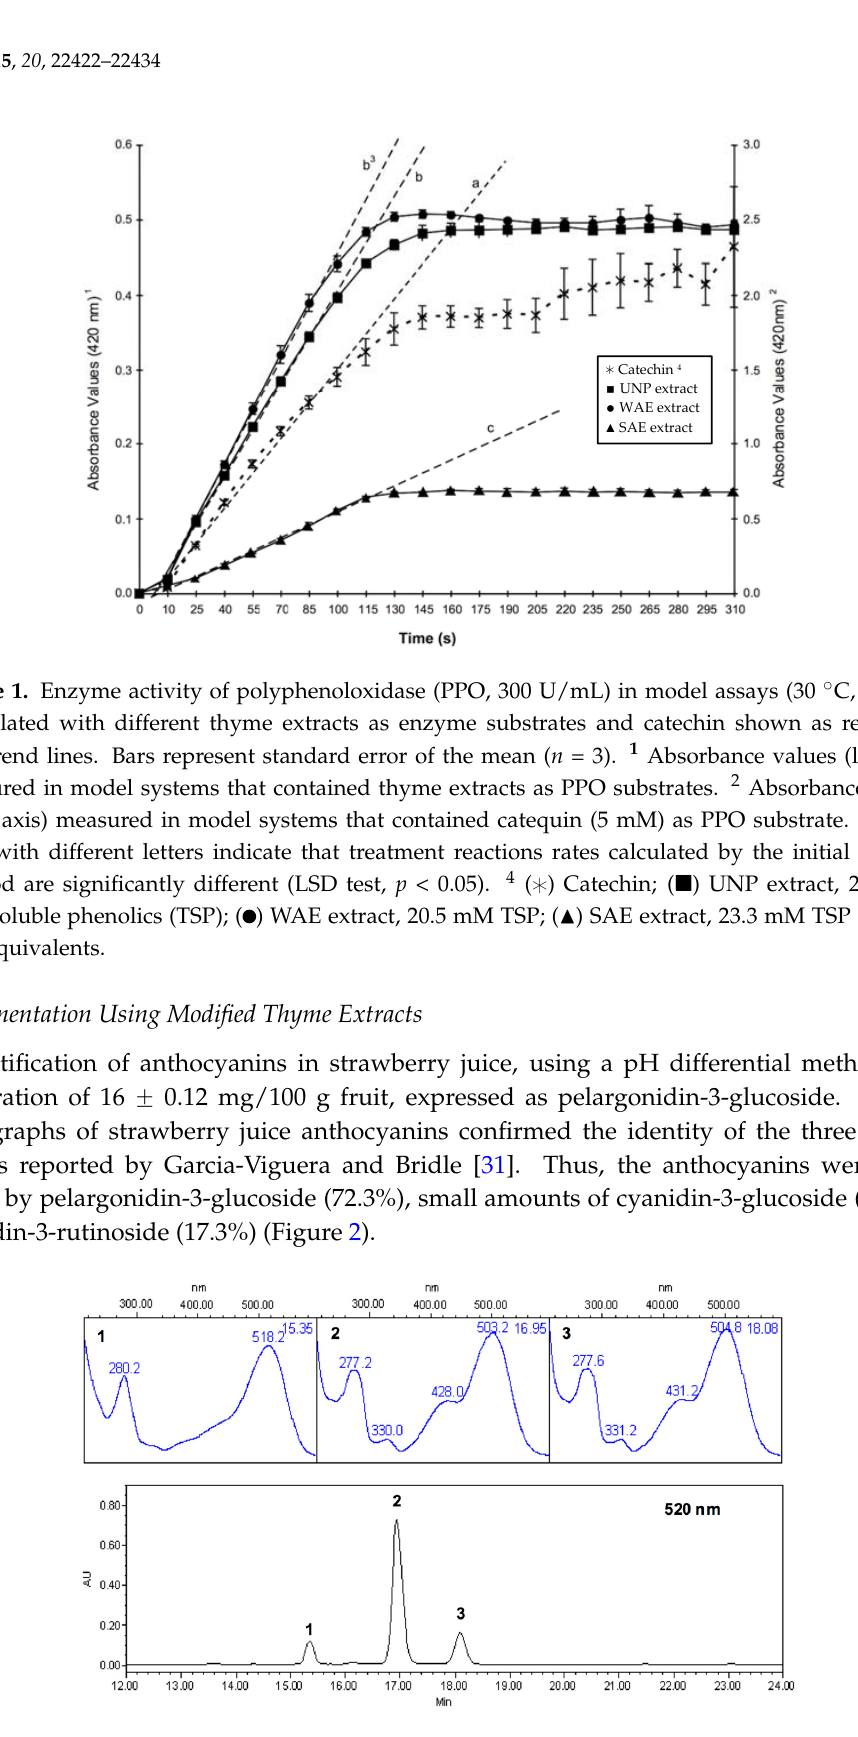
Figure 2. HPLC-PDA chromatogram of anthocyanins present in strawberry juice ( Fragaria anannassa L.) @ 520 nm, and UV-Vis spectra showing their chemical identity: ( 1 ) cyanidin-3-glucoside; ( 2 ) pelargonidin-3-glucoside; ( 3 ) possible pelargonidin-3-rutinoside.